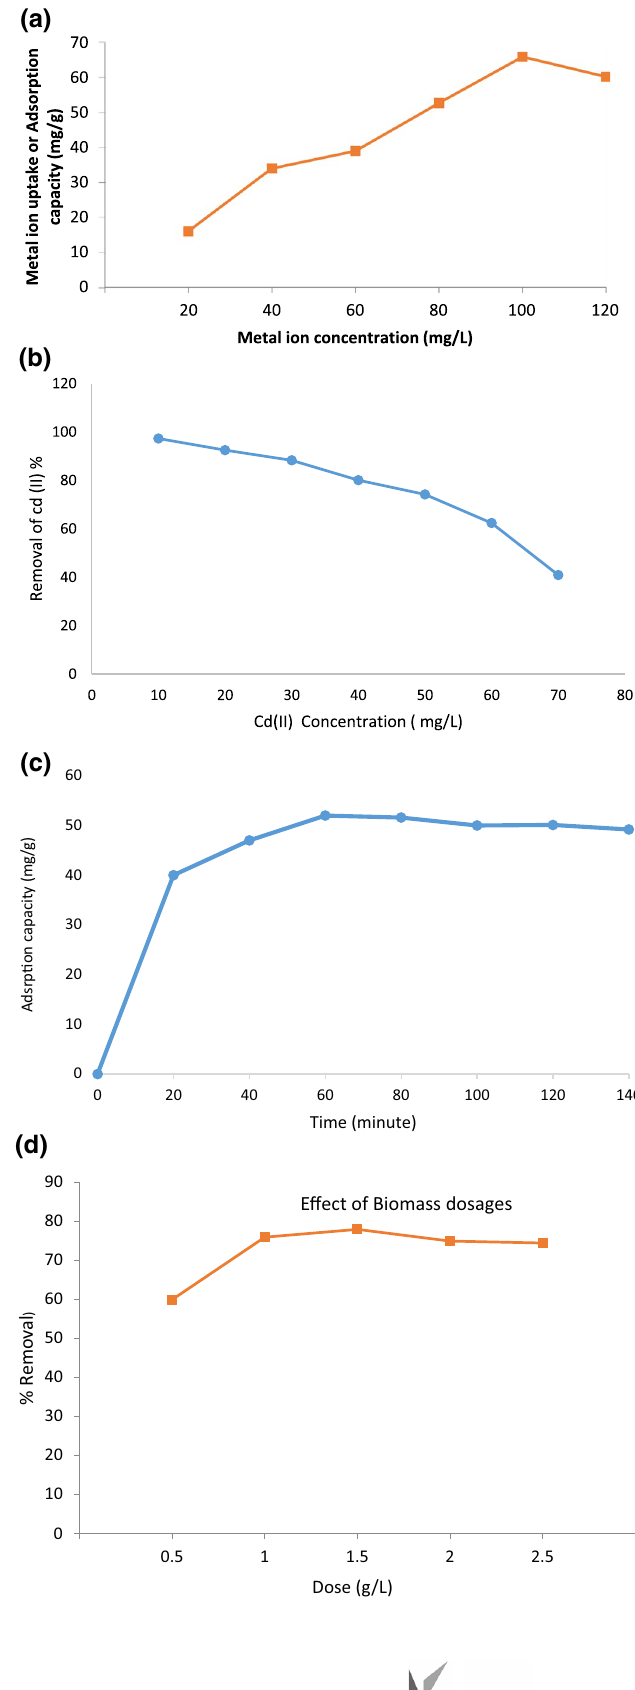
Fig. 5 a Effect of initial metal concentration on adsorption of Cd (II) on to Chlorella